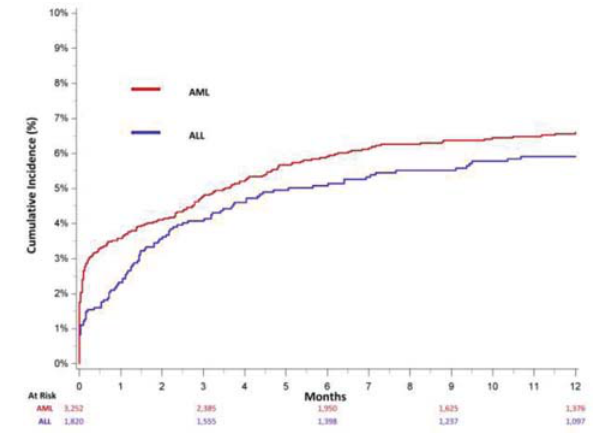
Fig. 1 Cumulative incidence of upper extremity deep vein throm- bosis, adjusted for the competing risk of death, among treated California acute leukemia patients, 2009 to 2014. AML, acute myeloid leukemia; ALL, acute lymphoblastic